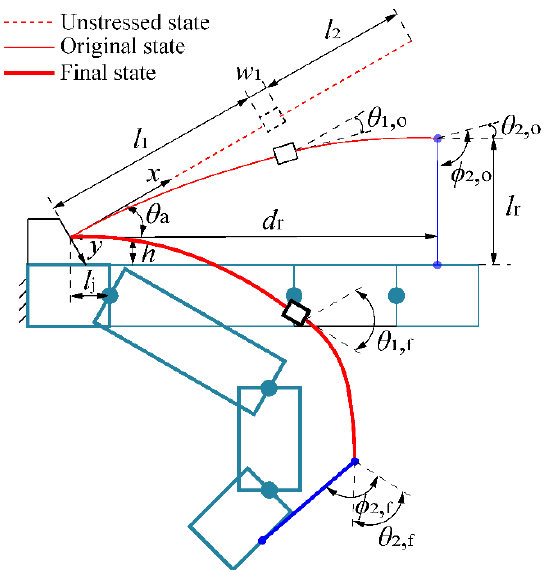
Figure 4. Human-machine coupling model based on human finger and V.